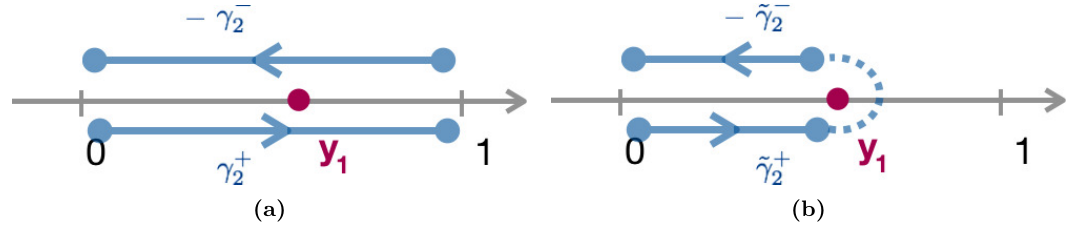
Figure 4. The contours present in the (cid:11) 0 -weighted commutator